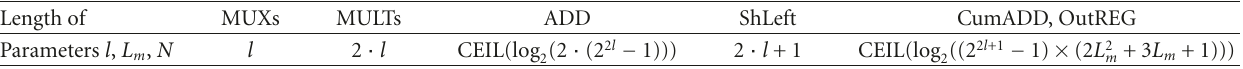
Table 6: Output registers lengths for used digital units depending on the parameters l , L m , and N . Length of